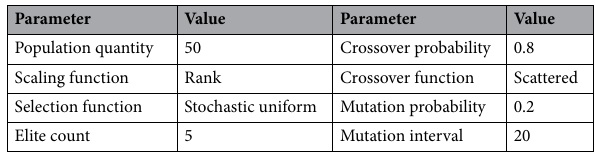
Table 2. Parameter of genetic